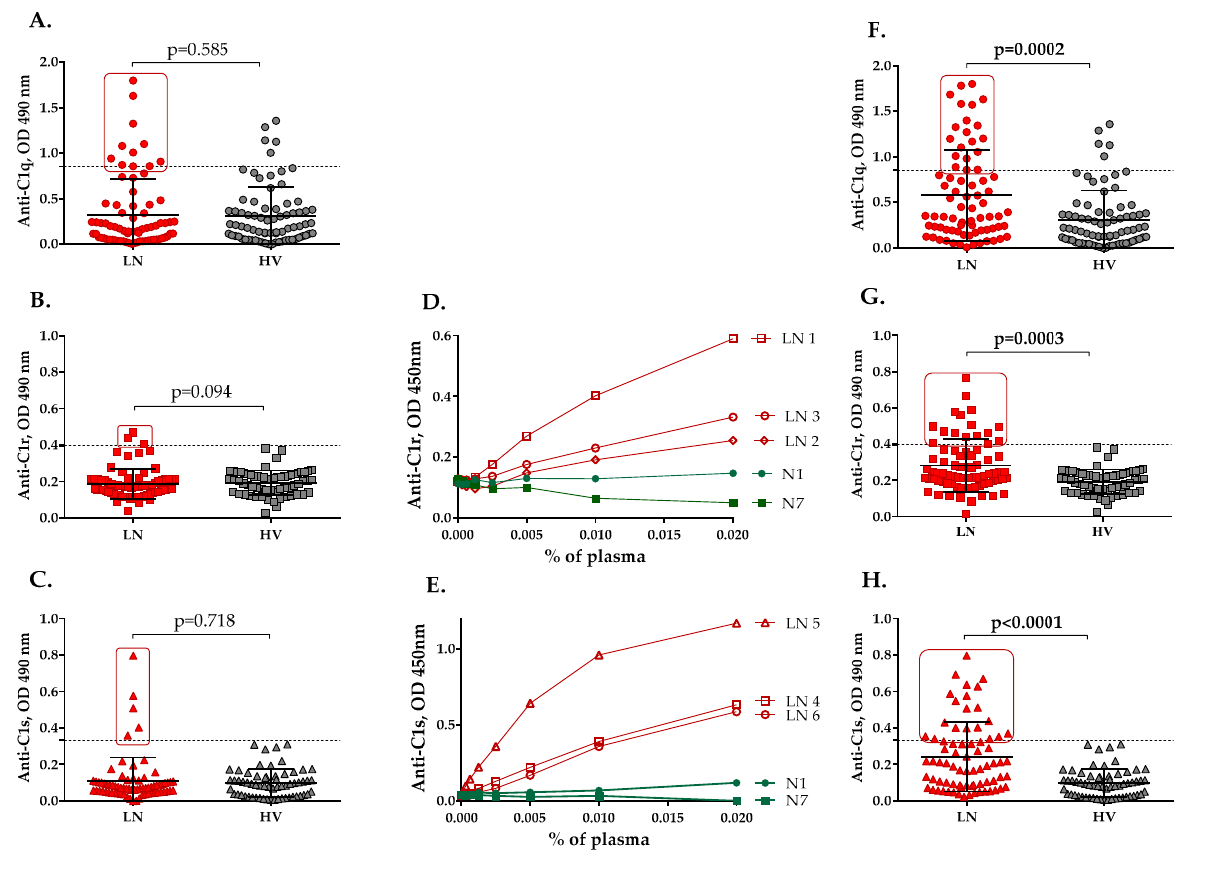
Figure 1. Presence of anti-C1 autoantibodies in LN. Reactivity against C1q ( A ), C1r ( B ) and C1s ( C ) from the plasma of patients with LN (LN) at the time of the first sampling, compared with healthy volunteers (HV), measured by ELISA. Reactivity against C1q ( F ), C1r ( G ) and C1s ( H ) from the plasma of patients with LN (samples with the highest levels of anti-C1 antibodies) (LN), compared with healthy volunteers (HV), measured by ELISA. The dotted line represents the positivity cut-off, determined as average ± 3 SD of the signal, obtained from the plasma of 81 healthy donors. N—normal control IgG, purified from healthy donors. Dose dependences of the IgG binding from different plasma samples to immobilized C1r ( D ) and C1s ( E ) were measured by ELISA. The autoantibody levels varied overtime for the patients that were positive for